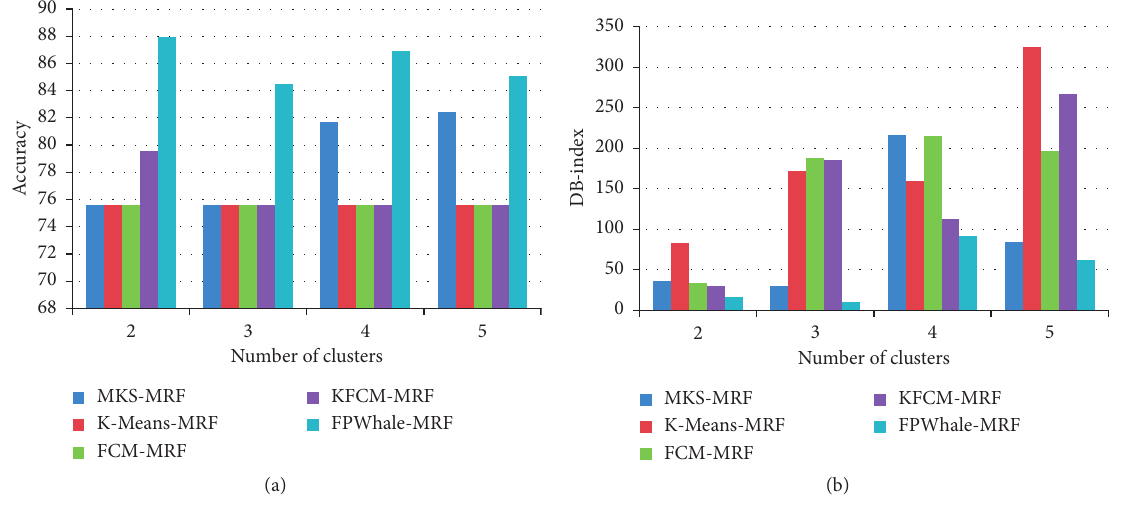
Figure 3: Comparison of effectiveness with different algorithms.